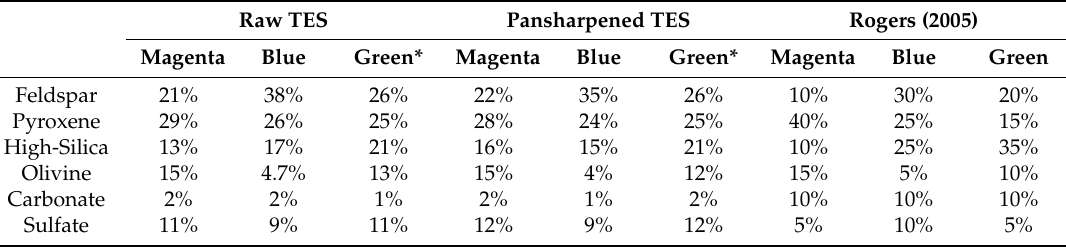
Table 5. Mineral group contribution means across three image types. “*Green*” unit averages are obtained only from images I08539014 and I08152027, as a Green unit could not be reliably isolated in I07815026.